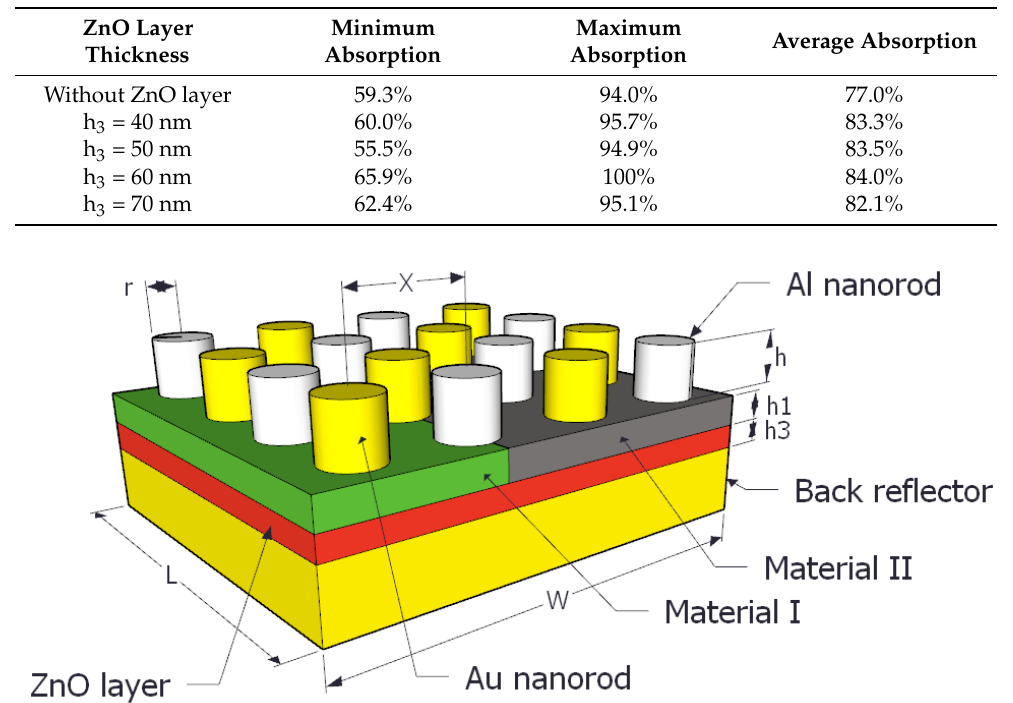
Figure 11. MMA side-by-side multi-dielectric layers structure with alternating nanorods distributed on ZnO substrate.